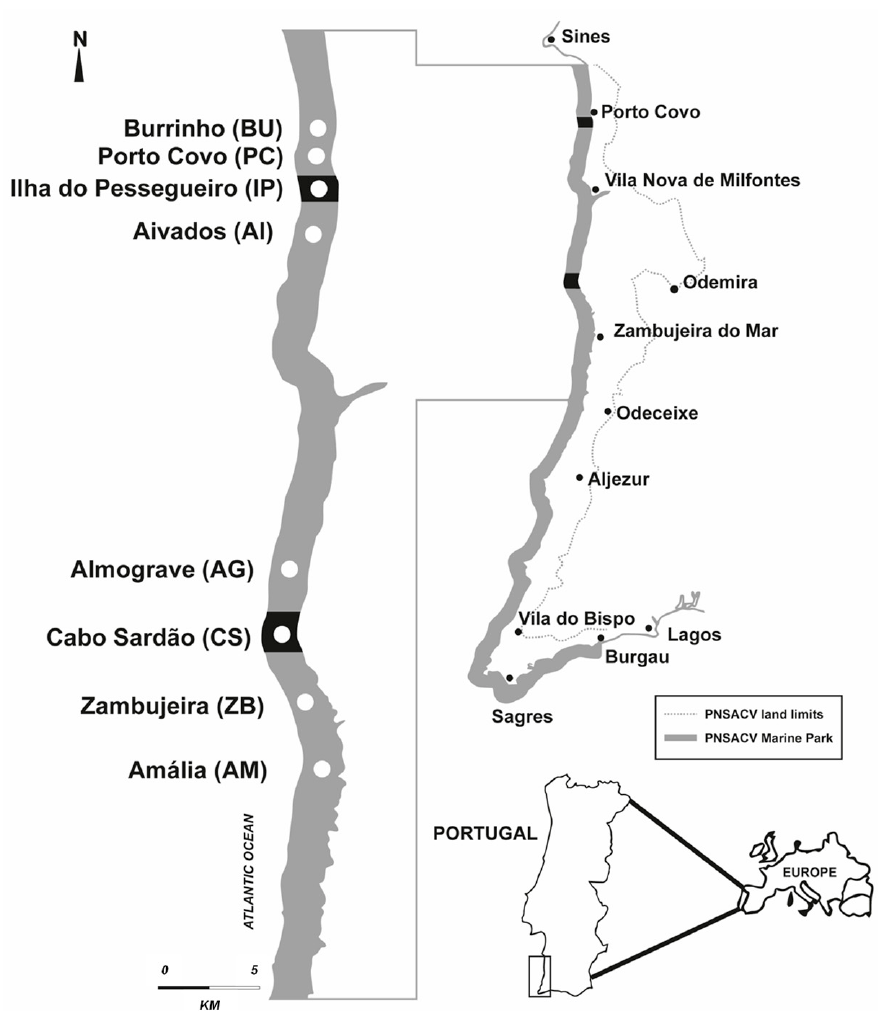
Figure 1. Study region and sampling areas in partial protected (PP) areas (Ilha do Pessegueiro and Cabo Sardão) and adjacent complementary protected areas (Burrinho, Porto Covo, Aivados, Almograve, Zambujeira, and Amália). The grey color indicates the marine area of the “Sudoeste Alentejano e Costa Vicentina” Natural Park (PNSACV); the PP areas of IP and CS are in black.